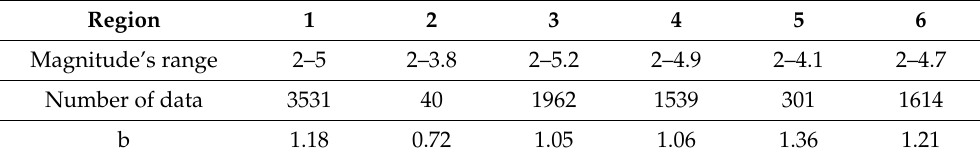
shocks as function of magnitude. Obtained b-values for each region are summarized Table A3. Table A3. b-values computed by regressing GR law (Equation (10)) on FMD of main shocks observed in instrumental seismicity for each SHARE region. Magnitude’s ranges and number of data used for regression are also detailed. Region numbers refer to Figure 4.